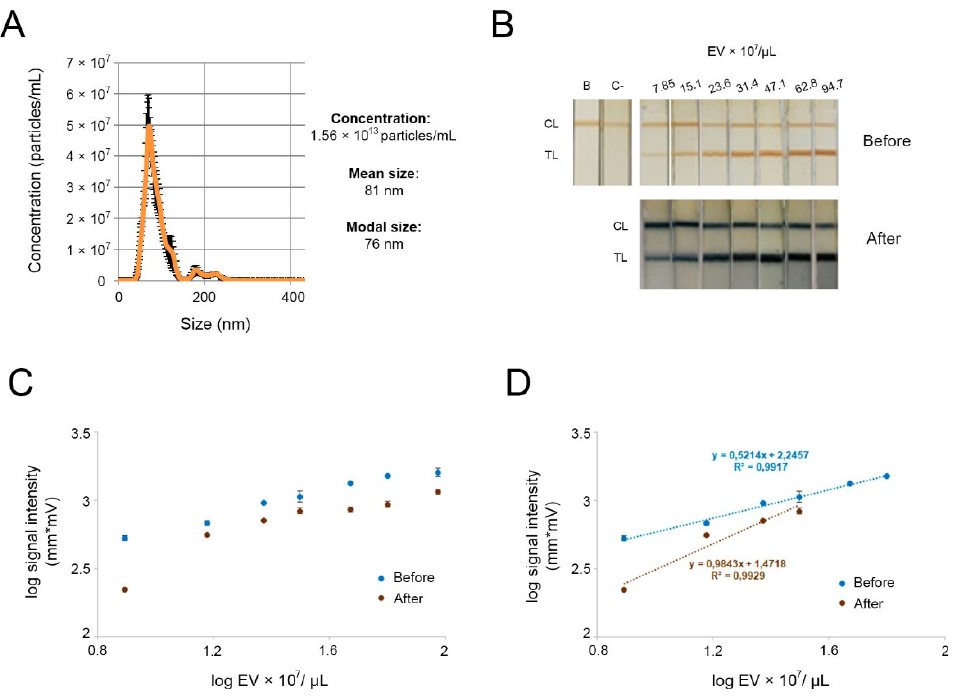
Figure 5. Signal enhancement for detection of different concentrations of plasma-derived EVs using anti-CD9 as capture antibody and MNP-OA-anti-CD63 as reporter label. ( A ) Concentration and hydrodynamic size distribution profiles of isolated EV, measured by NTA. ( B ) Representative image of the results obtained in the strips, before and after signal enhancement. B: blank; C-: EV-depleted plasma; CL: control line; TL: test line. ( C ) Calibration curve obtained with the LFIA optical reader, before (brown dots) and after (blue dots) signal enhancement. ( D ) Expanded view of the lower concentrations of EVs and the linear regression lines. Graphs show the means ± SDs ( n = 3).